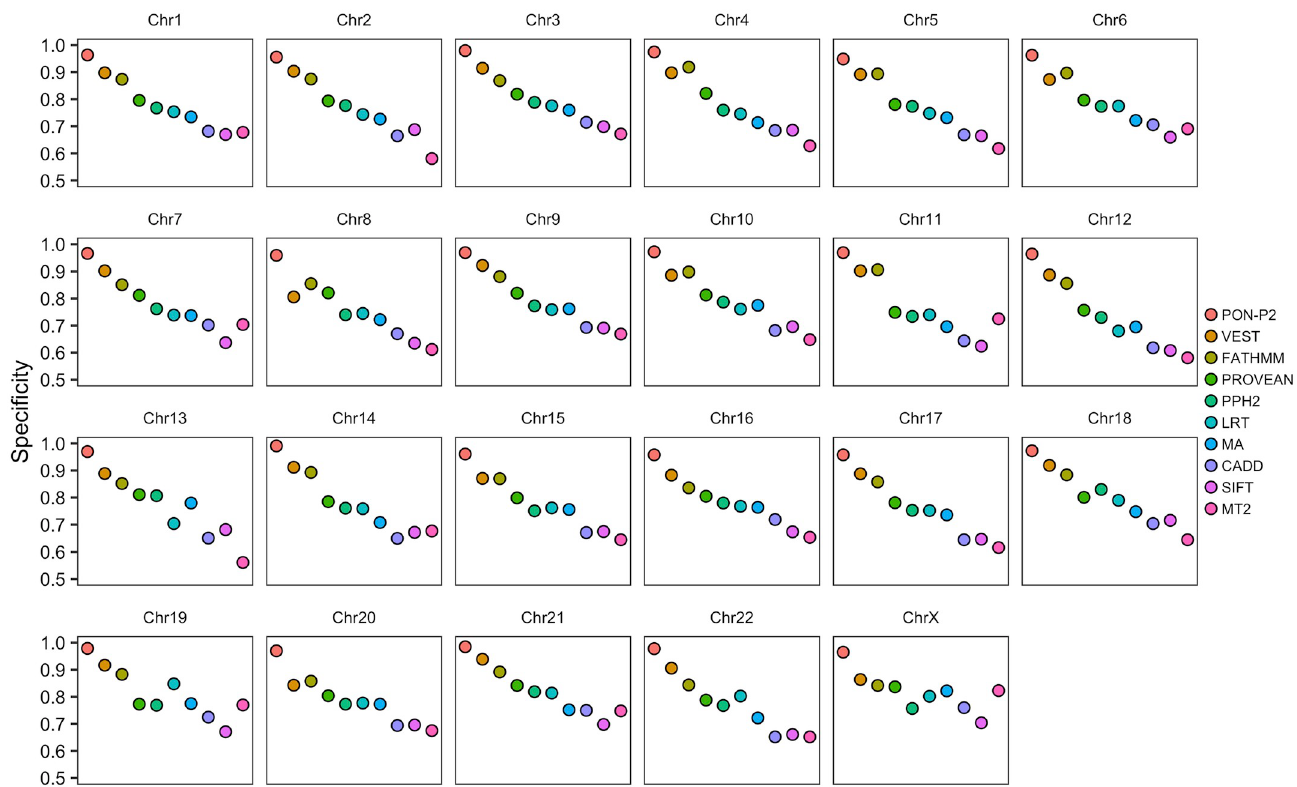
Fig 5. Chromosome-wise performance of tools. Variants in chromosome Y were excluded because there were only 3 variants. MA, Mutation Assessor; MT2, MutationTaster2; PPH2,